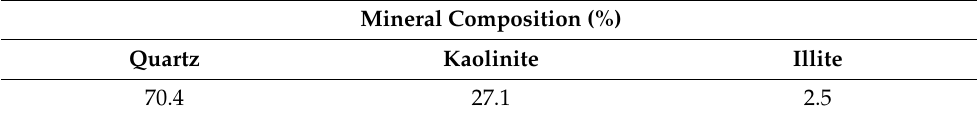
Table 2. Mineral composition of the granite residual soil.